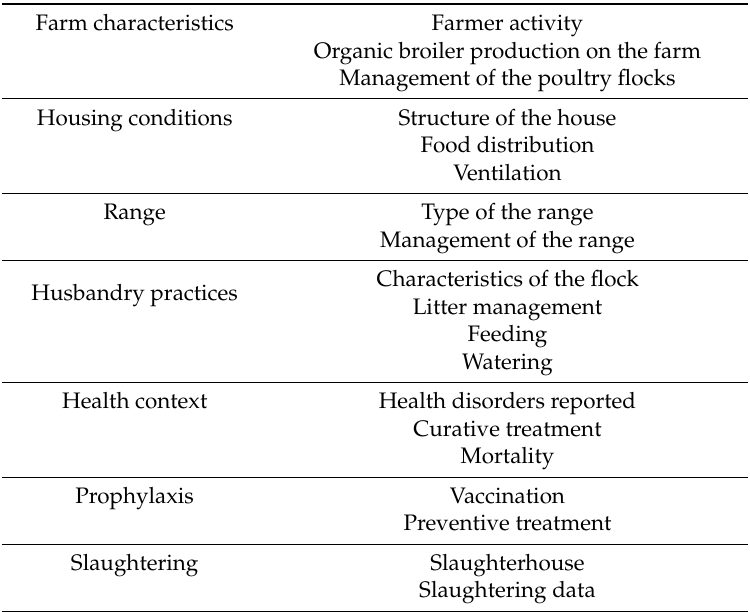
Table 1. Summary of the items included in the survey